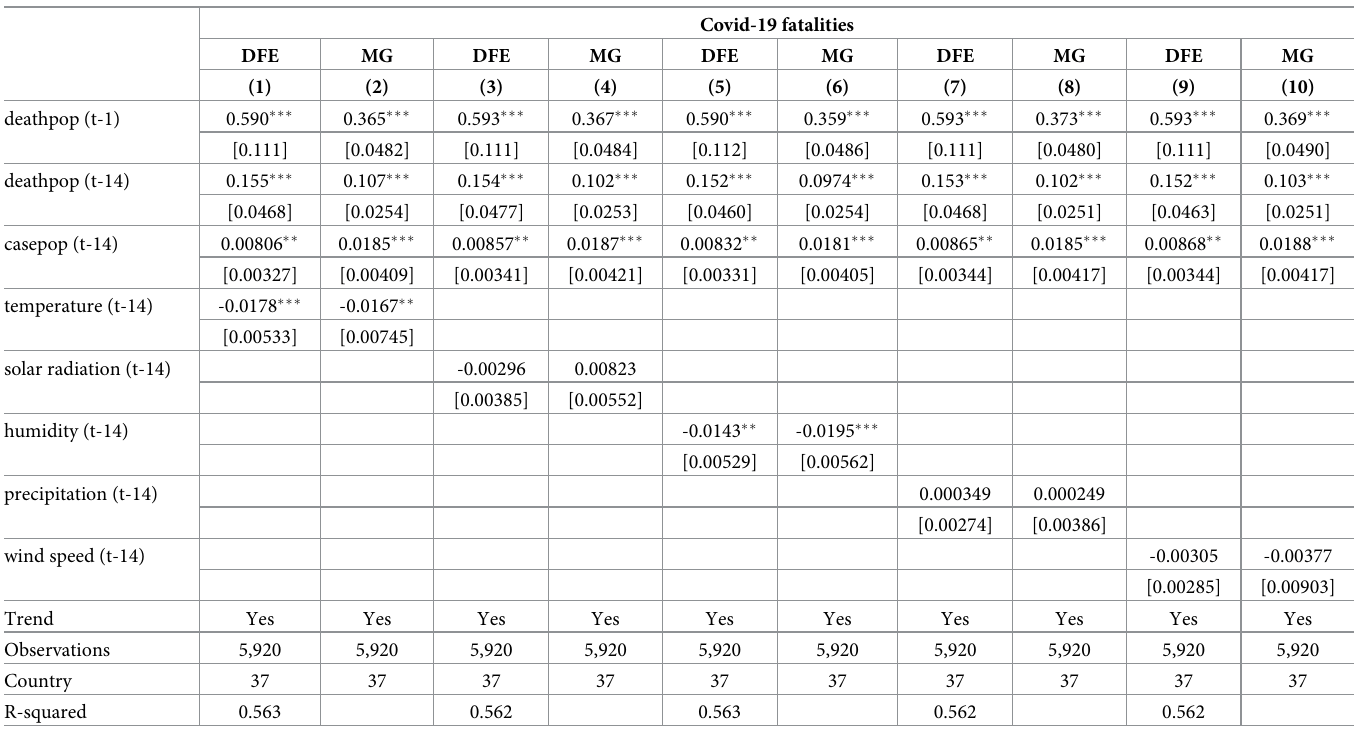
Table 5. Direct effects of climate variables on Covid-19 fatalities.